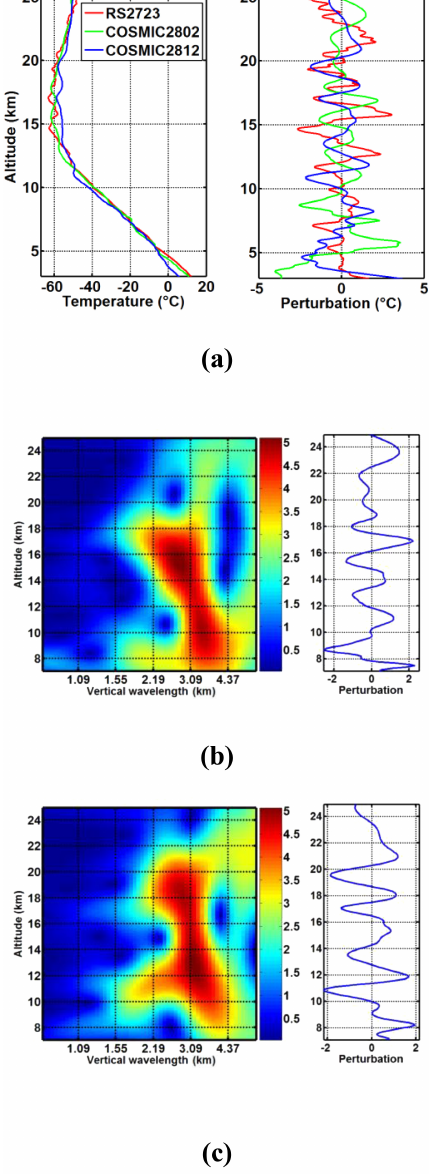
Figure 7. (a) Vertical profiles of temperature ( ◦ C) and perturbations ( ◦ C) on the left and right panels from RS and RO data on 27 July at 23:03, 28 July 2013 at 02:00 and 12:00UTC respectively. Mor- let CWT (left panel) of temperature perturbations (right panel) of GPS-RO data on 28 July 2013 at (b) 02:00UTC and (c) 12:00UTC. Colour scale: red relatively high values, blue relatively low values.